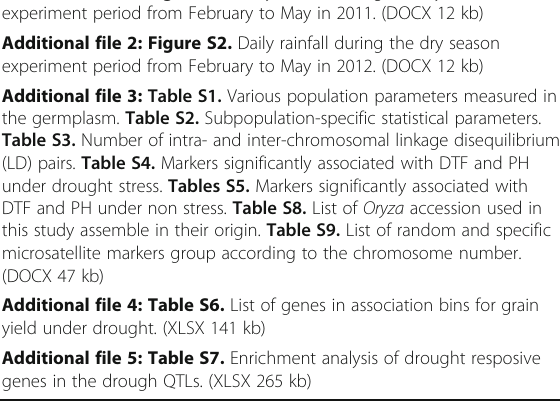
Additional file 3: Table S1. Various population parameters measured in the germplasm. Table S2. Subpopulation-specific statistical parameters. Table S3. Number of intra- and inter-chromosomal linkage disequilibrium (LD) pairs. Table S4. Markers significantly associated with DTF and PH under drought stress. Tables S5. Markers significantly associated with DTF and PH under non stress. Table S8. List of Oryza accession used in this study assemble in their origin. Table S9. List of random and specific microsatellite markers group according to the chromosome number. (DOCX 47 kb) Additional file 4: Table S6. List of genes in association bins for grain yield under drought. (XLSX 141 kb) Additional file 5: Table S7. Enrichment analysis of drought resposive genes in the drough QTLs. (XLSX 265 kb) Abbreviations CV: Coefficient of variation; DS: Dry season; DTF: Days to 50% flowering; GSL: Genotyping Services Laboratory; GY: Grain yield; IRRI: International